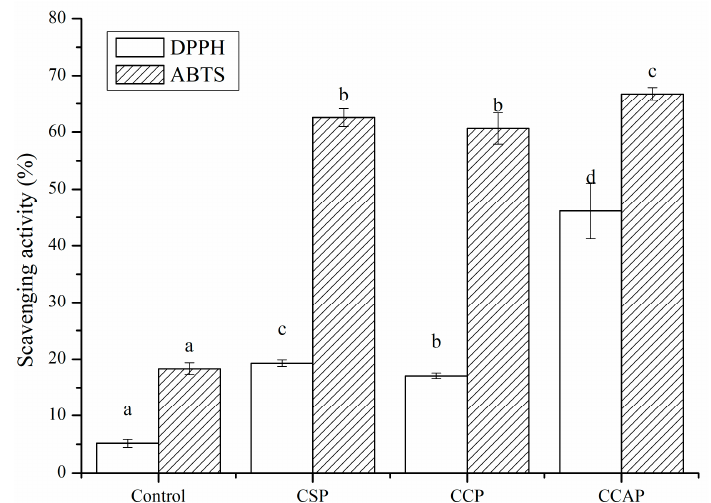
Figure 10. Antioxidant activity of chitosan (control) and peptide − containing films. CSP: films from chitosan and soy protein peptides; CCP: films from chitosan and corn protein peptides; CCAP: films from chitosan and casein peptides. Results having different letters (a − d) in same pattern are significantly different ( p < 0.05).